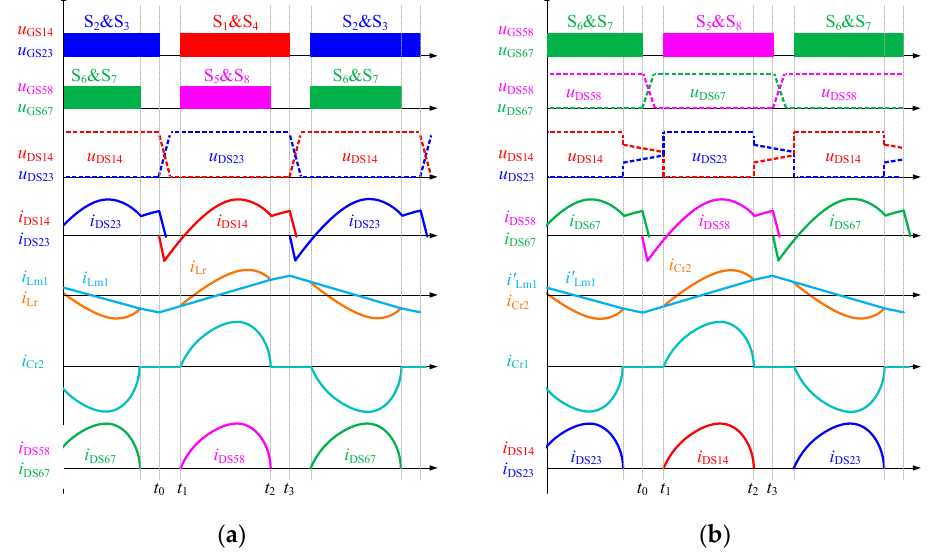
Figure 2. The current and voltage waveforms of CLTC multi-resonant converter: ( a ) forward mode; ( b ) backward mode.